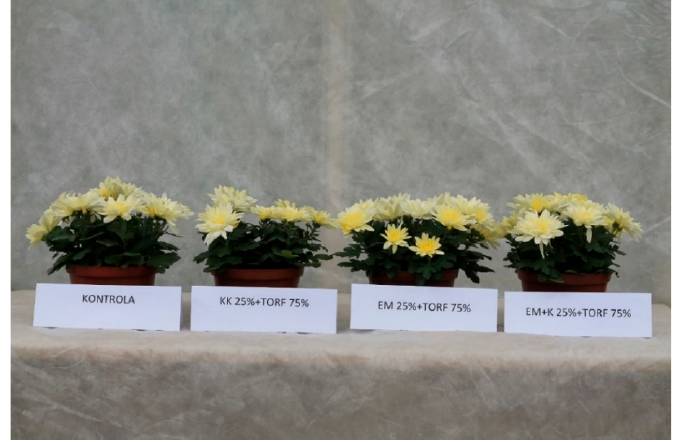
Figure 3. The quality of chrysanthemum (KONTROLA-control, KK25% + TORF 75%-compost KK 25% + peat 75%, EM 25% + 75%TORF-compost EM 25% + peat 75%, EM + K 25% + 75%TORF-compost EM + 25% + peat 75%).